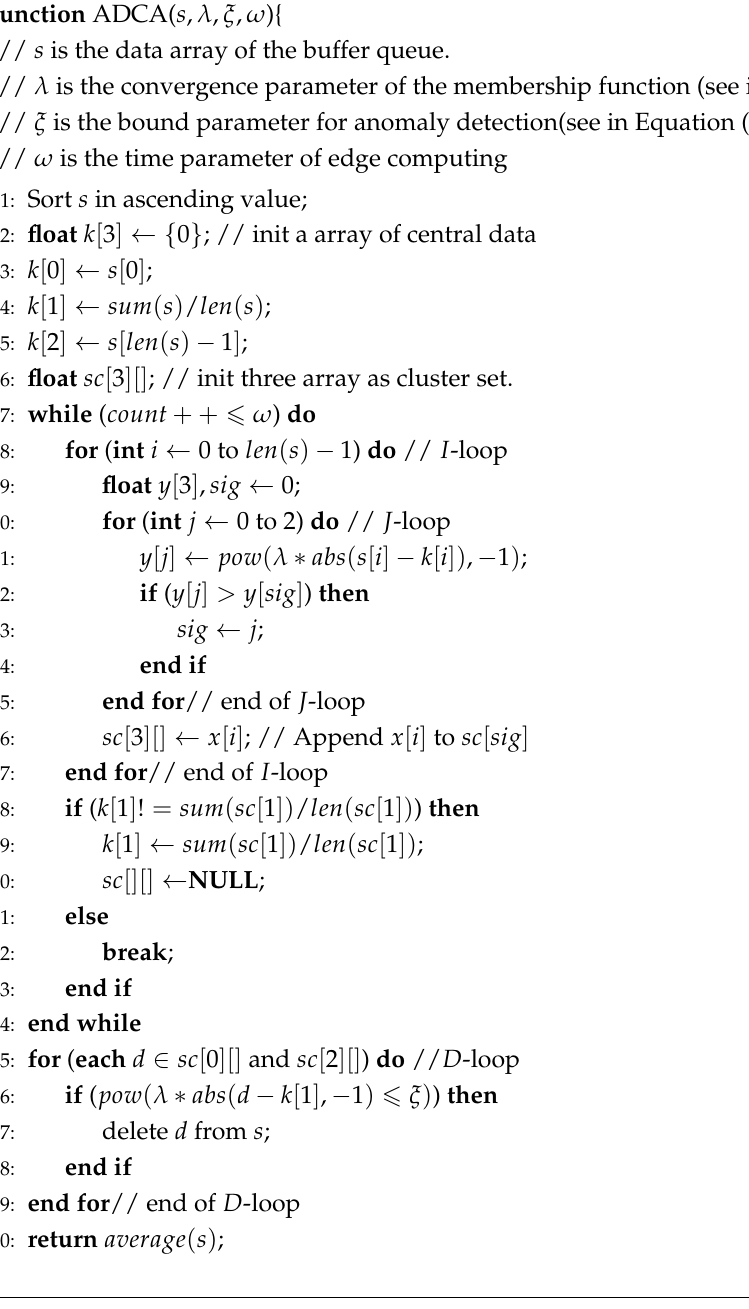
Algorithm 1 Anomaly data clustering algorithm of the sensor